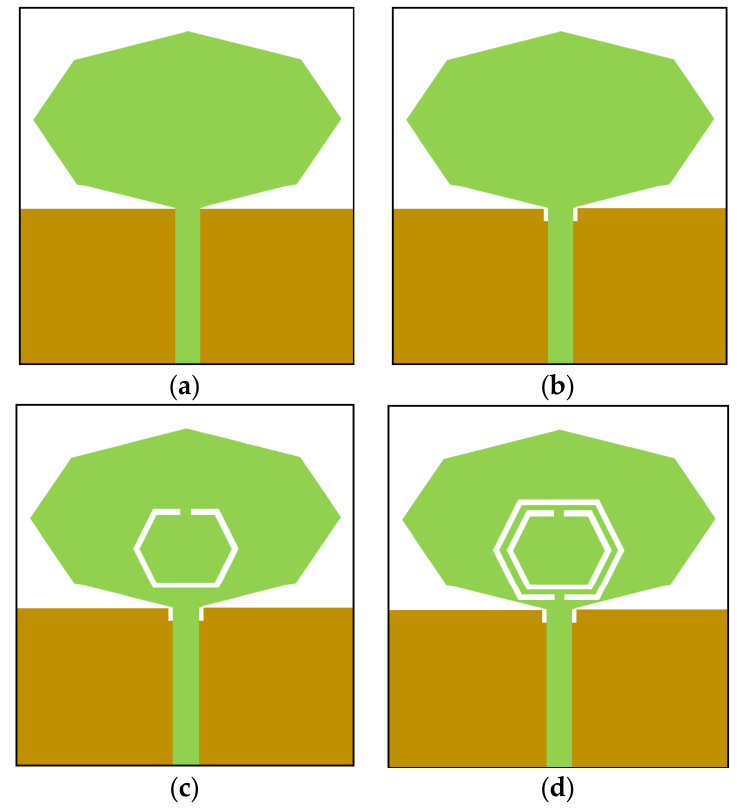
Figure 2. Octagonal-shaped monopole antenna design steps: ( a ) stage-1; ( b ) stage-2; ( c ) stage-3; ( d ) stage-4.